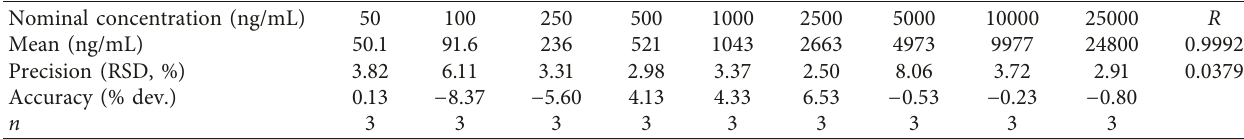
Table 1: Interday average backcalculated standard concentrations ( n � 3).